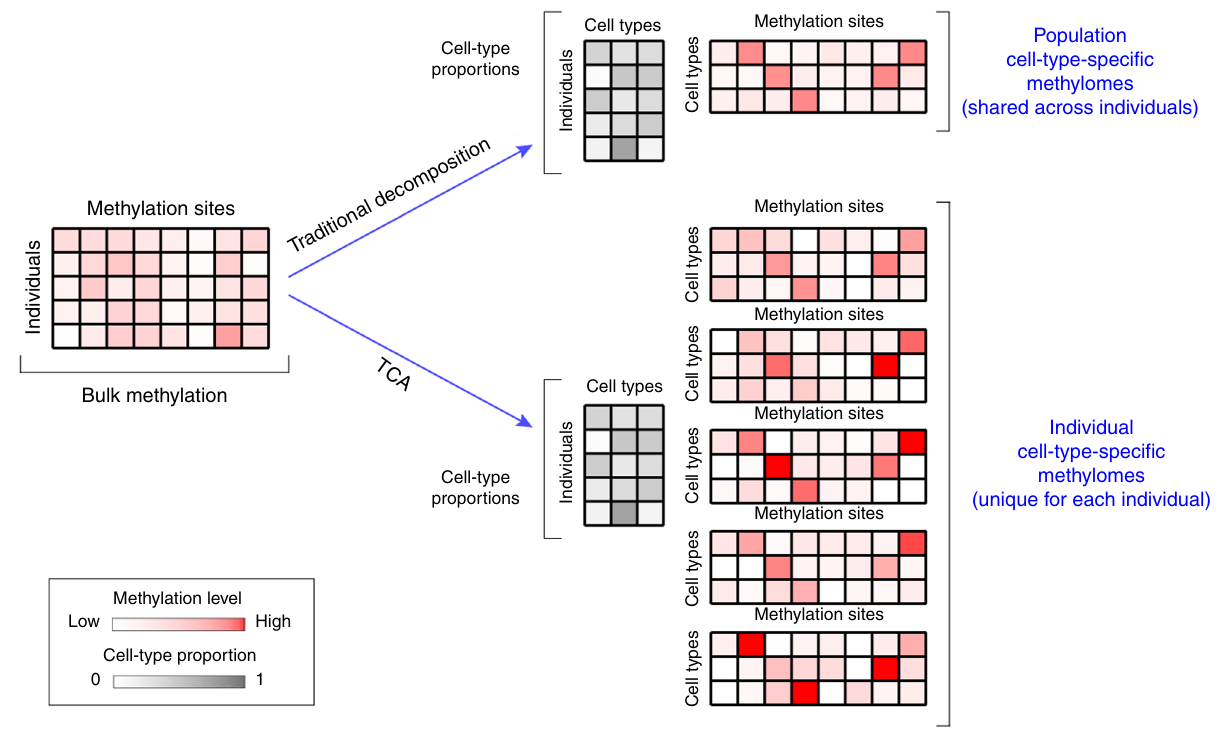
Fig. 2 TCA versus a traditional decomposition approach. Given bulk DNA methylation data from a heterogeneous tissue, previous decomposition methods (e.g., PCA, ReFACTor 33 , or a reference-based decomposition 26 ) aim at estimating a matrix of the cell-type proportions of the individuals and a matrix of the cell-type-speci fi c methylomes in the sample (shared across individuals). In contrast, TCA aims at estimating a matrix of the cell-type proportions of the individuals and — for each individual — a matrix of the unique cell-type-speci fi c methylomes of the